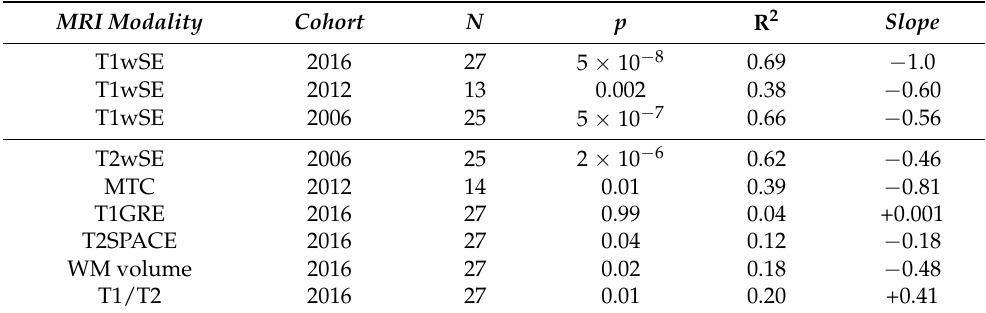
Table 3. For nine Healthy Control MRI image-sets from 3 cohorts, correlations between subcortical and sensorimotor ROI medians. Correlation statistical inference p , R 2 and linear fit slope = Dsensori- motor/Dsubcortical are